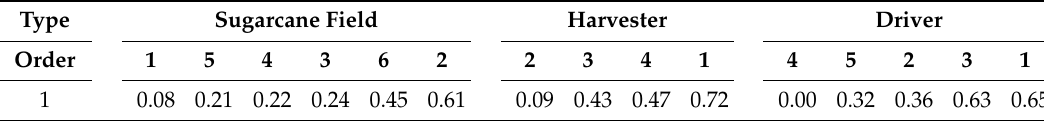
Table 3. Results of sorting value in the position of vector